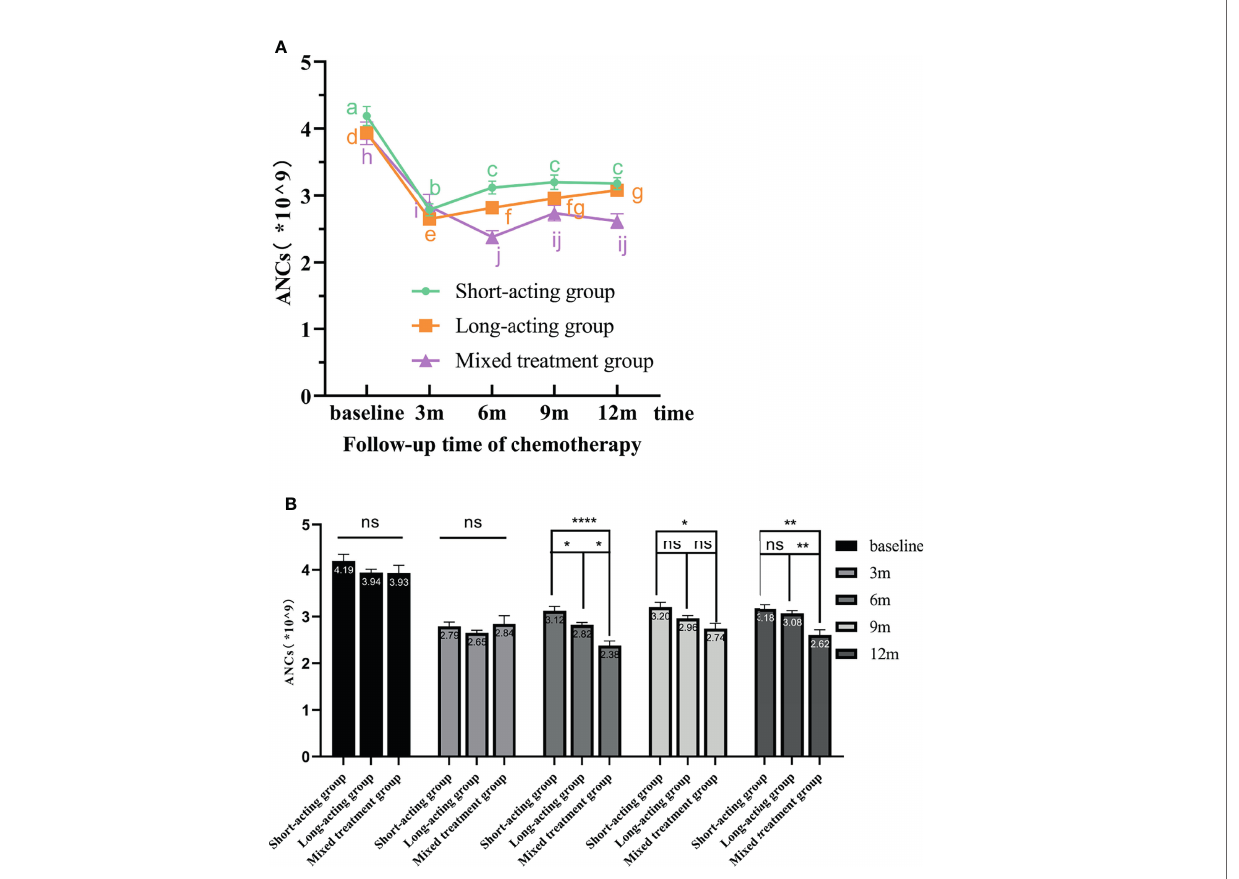
FIGURE 4 | The variation tendency of ANCs in different G-CSF treated groups. (A) The line chart shows the recovery tendency of ANCs in the three different G-CSF treatment groups. The different letters (a – j) on the line chart indicate signi fi cant intra-group differences at various time points ( p < 0.05). (B) Bars represent the ANCs means ± standard error of the mean (SEM) from the three G-CSF groups. “ ns ” indicates that there are no signi fi cant inter-group differences. * indicates signi fi cant inter-group differences at each time point ( p < 0.05 indicated by *, p < 0.01 indicated by **, and p < 0.0001 indicated by ****). ANCs, absolute neutrophil counts; rhG-CSF, recombinant human granulocyte colony-stimulating factor; PEG-rhG-CSF, pegylated recombinant human granulocyte colony-stimulating factor; G-CSF, granulocyte colony-stimulating factor; SEM, standard error of the